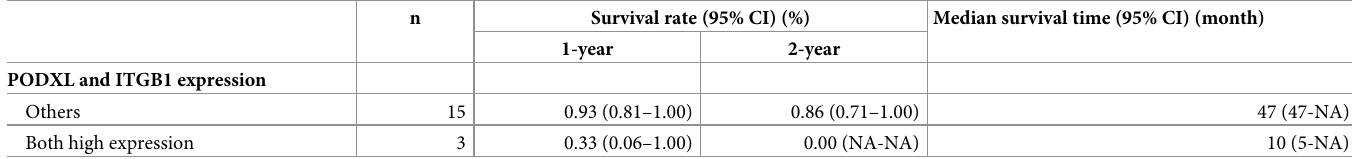
Table 4. Survival rates and median survival times of the combination of PODXL with ITGB1 at UICC stage